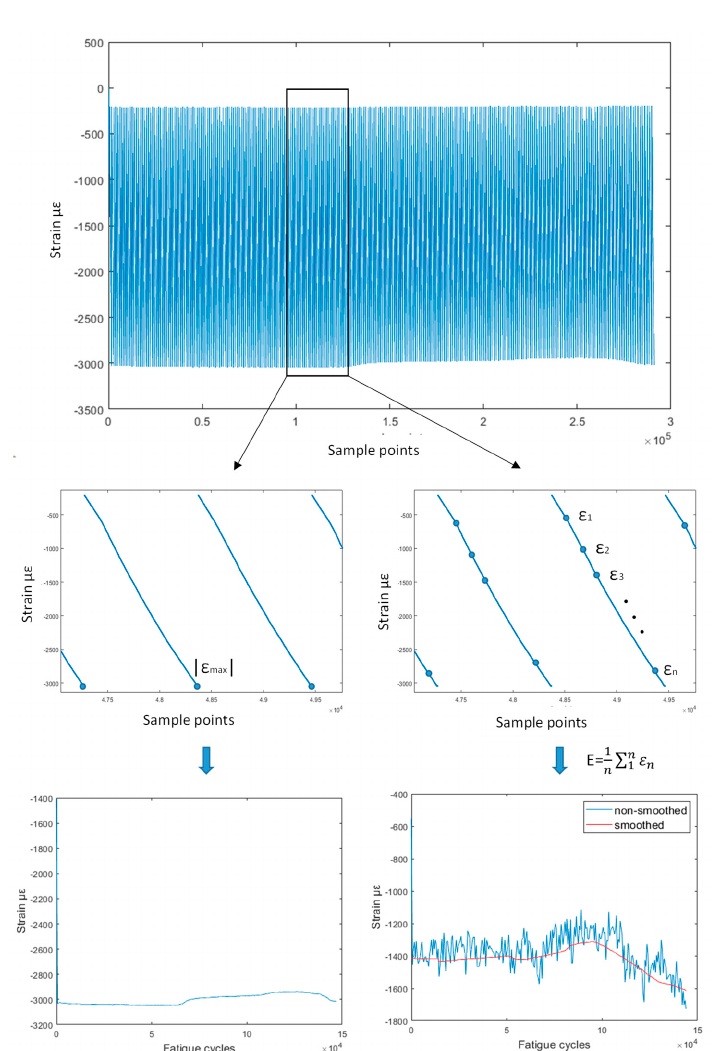
Figure 3. The raw strain collected at each quasistatic test is presented in the top figure. The maximum strain value from each quasistatic is extracted and creates the strain histories for method 1 ( left ). n strain points from each quasistatic are randomly sampled and then averaged and smoothed to create the strain histories for method 2 ( right ).